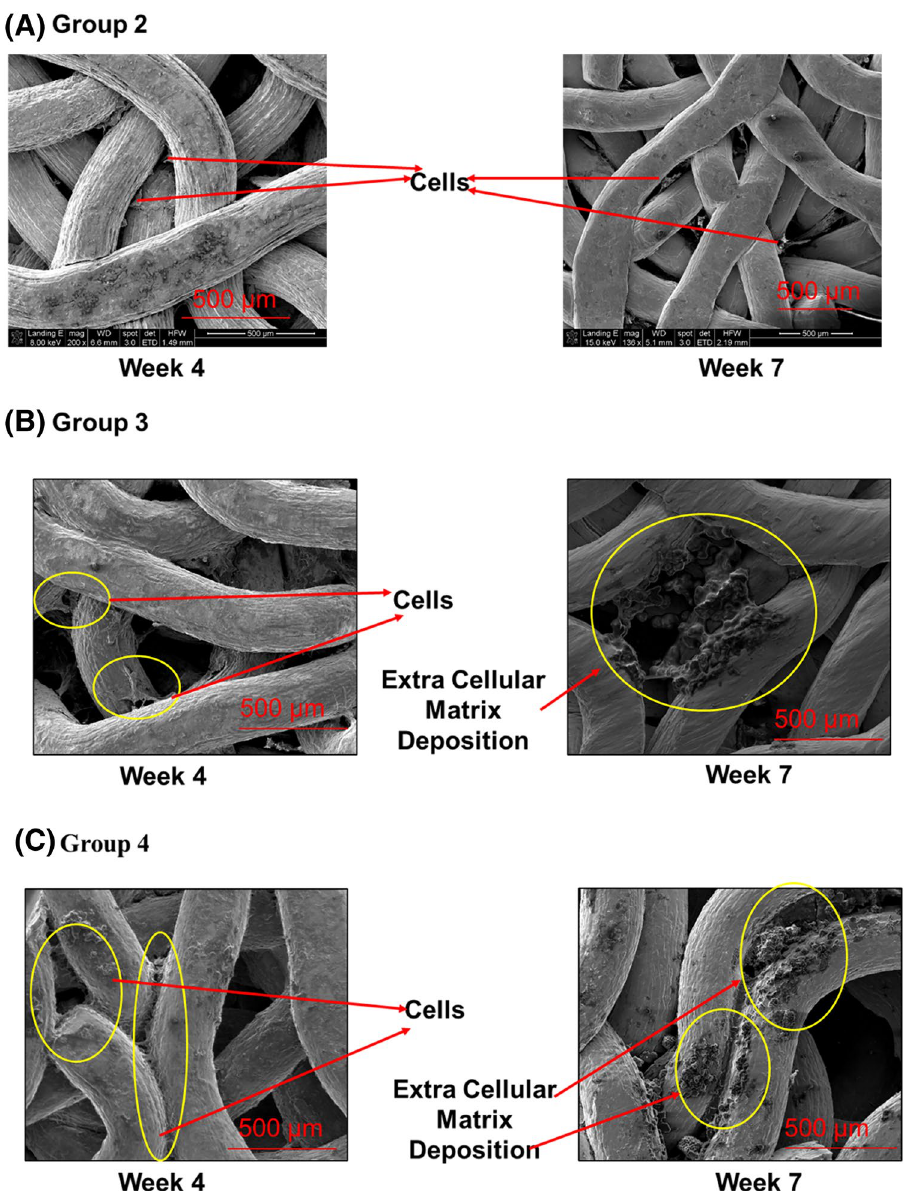
culture ( B ) Fiber-mesh metallic scaffold in contact with bone under a pressure of 150 kPa in static culture ( C ) Fiber-mesh metallic scaffold in contact with bone core and exposed to cyclic loading with continuous perfusion flow of media within the ex-vivo culture